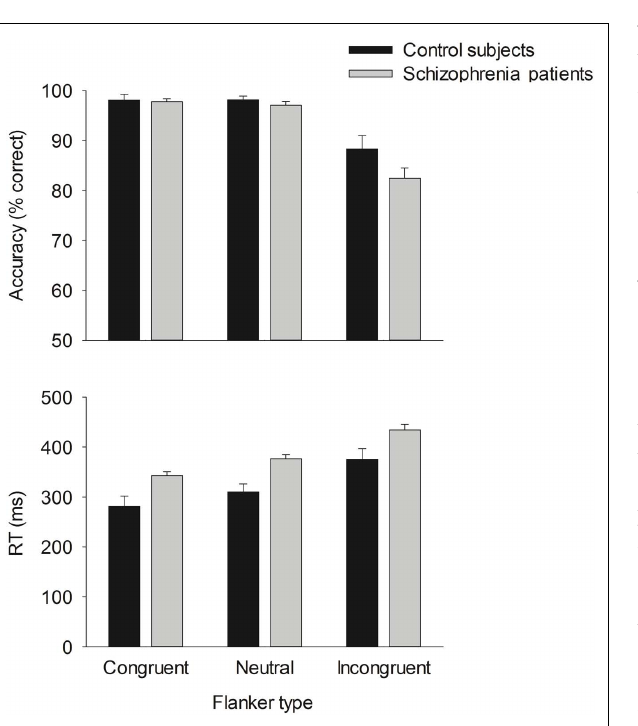
FIGURE 4 | Mean accuracy (top) and RT (bottom) for the flanker task. Error bars indicate